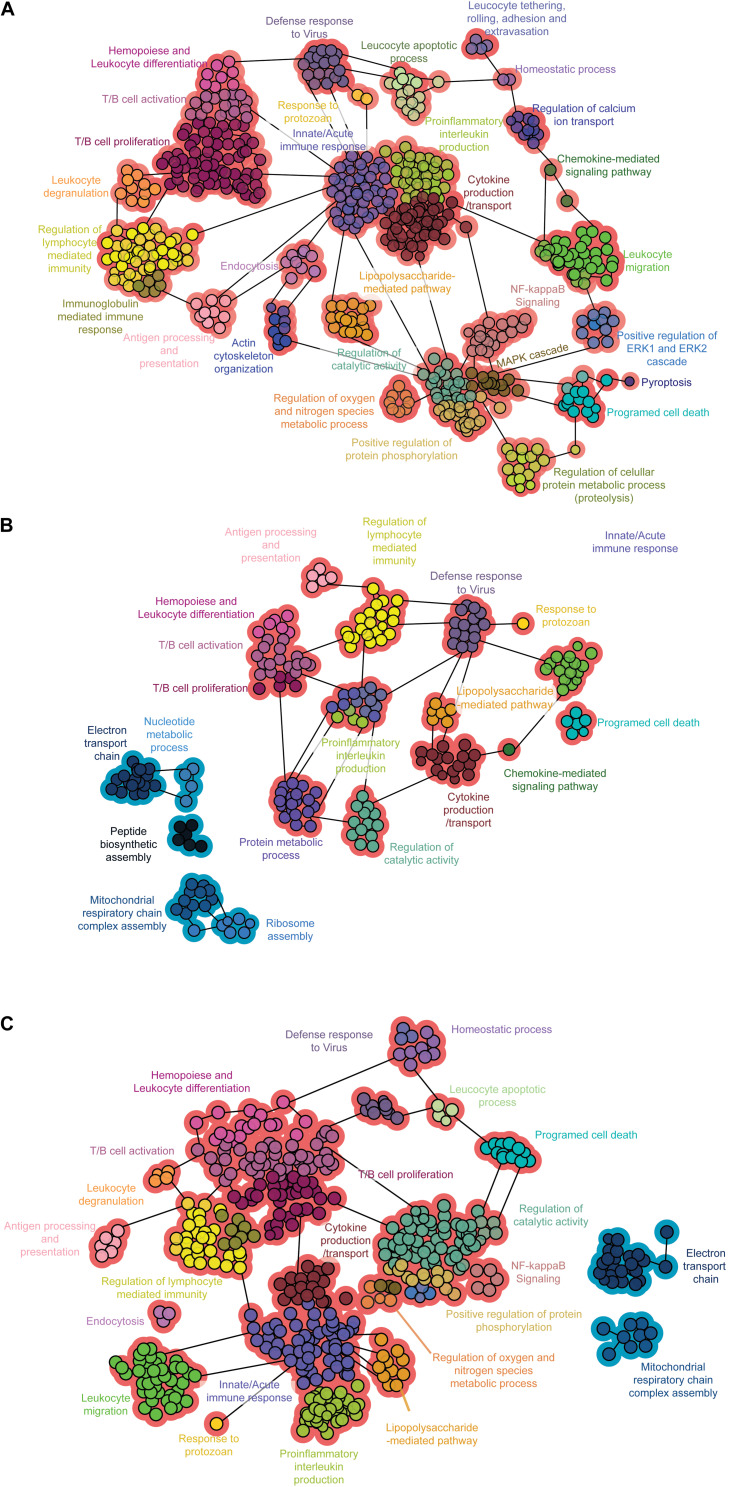
Functional networks of enriched biological processes. Network of the biological processes in the (A) Col1. 7G2-, (B) JG-, and (C) mixture-infected groups. Functional groups with more than 90% upregulated or downregulated genes are shown in red or blue, respectively. The data represent only gene clusters with p < 0.001 after Bonferroni step-down correction.